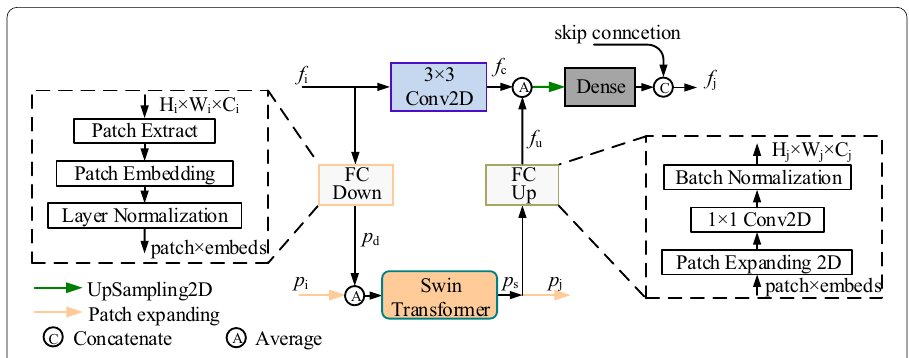
Fig. 1 The diagram of the dual-path hybrid